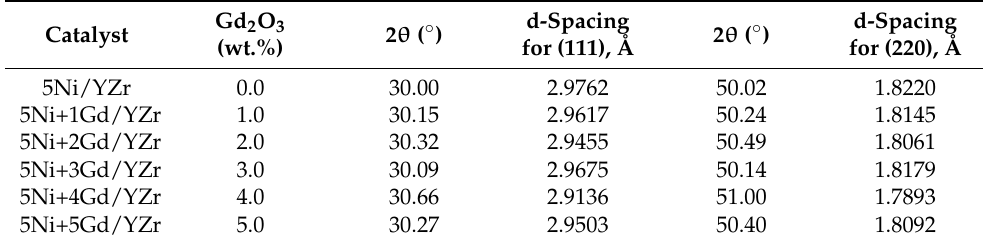
Figure 4. The XRD patterns of ( A ) the fresh catalysts and ( B ) the spent catalysts (black labels for mesoporous YZr support, green label for Gd 2 O 3 promoter, and blue label for NiO). Table 3. The shift in the 2 θ angle and change in the d-spacing of (111) and (220) crystallographic planes of cubic yttria-stabilized zirconia phase for the spent